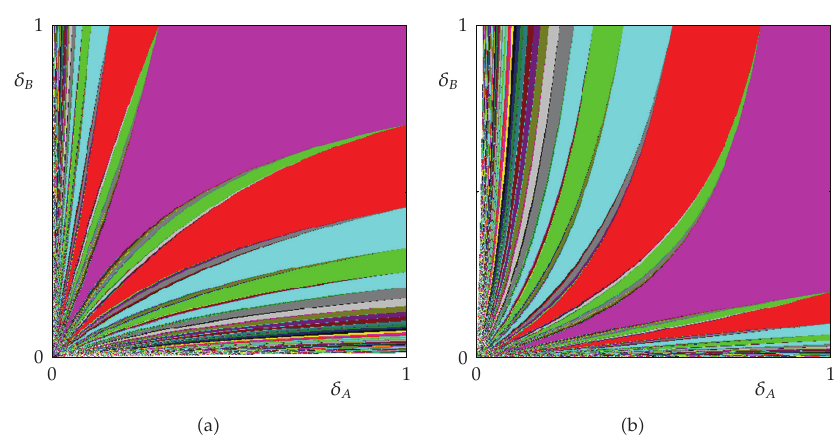
Figure 10: Bifurcation diagrams in the parameters’ plane (cid:2) δ A ,δ B (cid:3) obtained with di ff erent values of the discontinuity point (cid:2) a (cid:3) d (cid:7) 0 . 3; (cid:2) b (cid:3) d (cid:7) 0 .